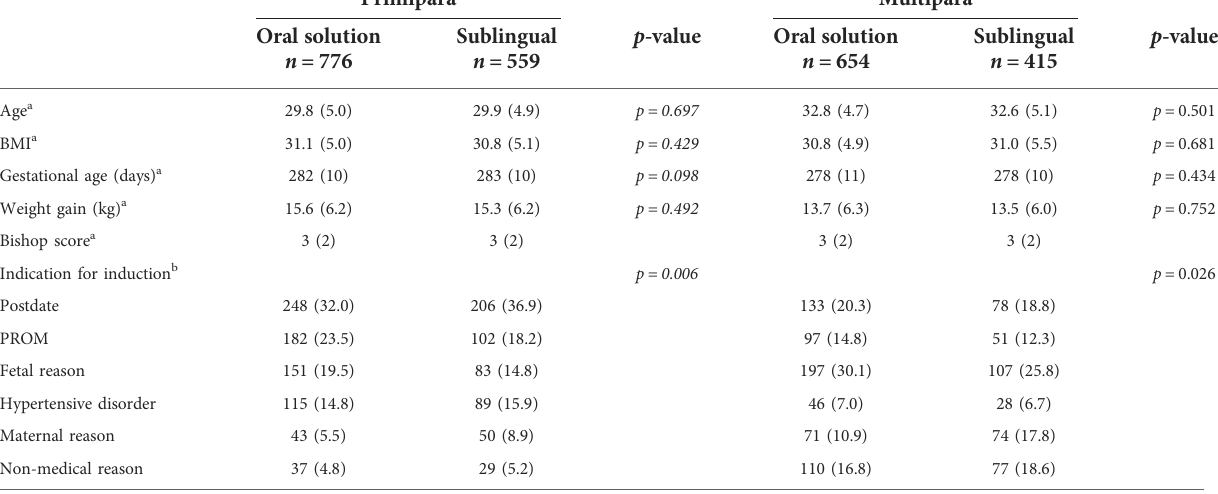
TABLE 1 Demographic characteristics.